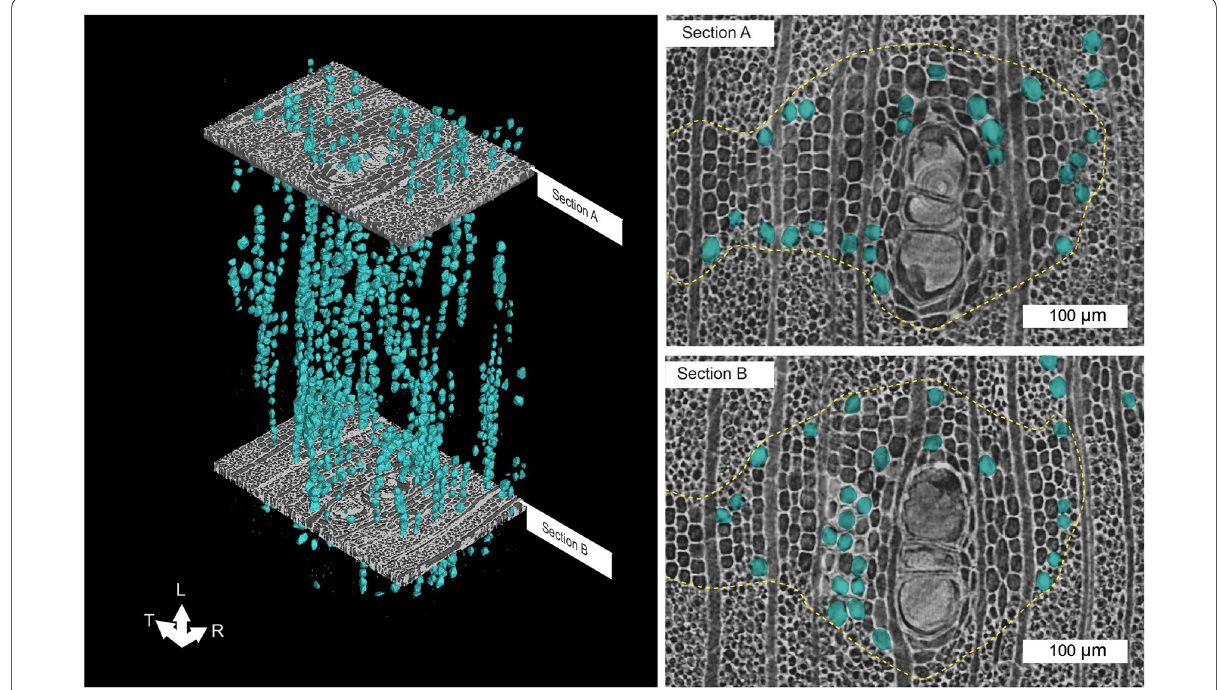
Fig. 4 Spatial arrangement of the prismatic crystals surrounding the vessels in sheath 3. Left: 3D visualization of the wood by isolating the prismatic crystals (blue) and two consecutive transverse sections (sections A and B). Right: 2D views of sections A and B. The yellow dashed line is the boundary between the axial parenchyma and fiber cells. L longitudinal direction, R radial direction, T tangential